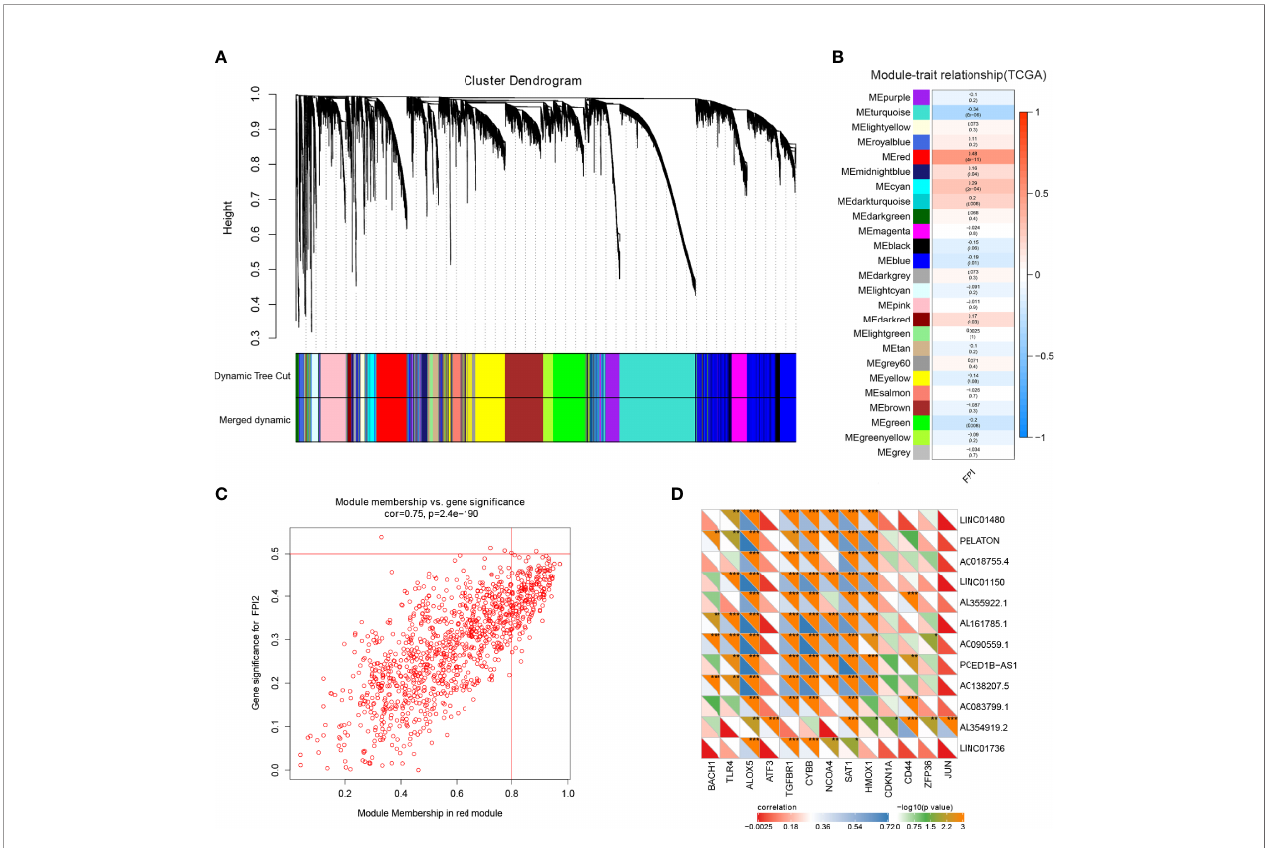
FIGURE 1 | Ferroptosis gene identi fi cation in GBM. (A) Dendrogram of all highly expressed genes clustered based on a dissimilarity measure (1-TOM) together with assigned module colours in the GBM cohort of TCGA. (B) Heatmap of the correlation between module genes and FPI in GBM. Each range contains the Pearson correlation coef fi cient and P value. (C) Signi fi cant correlation between the module membership of the red module and FPI gene signi fi cance. (D) Identi fi cation and correlation of 13 known ferroptosis-associated mRNAs and 12 unreported ferroptosis lncRNAs by Pearson correlation analysis from 610 DEGs (*p < 0.05; **p < 0.001; ***p <